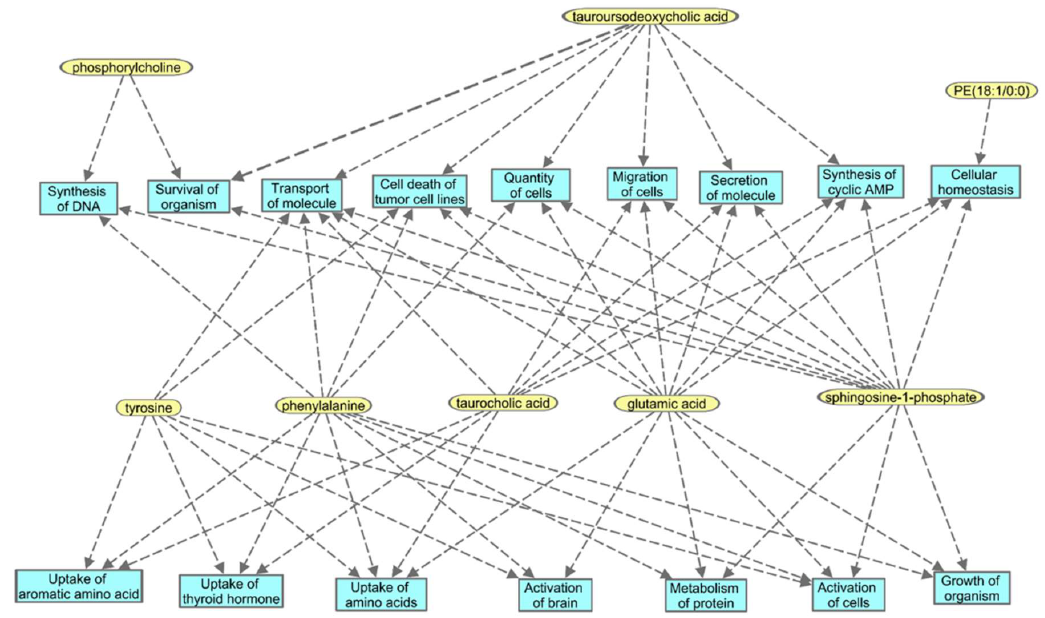
Figure 6. Functional pathway analyses for transient changes in metabolite expression identified changes in glycerophospholipid and bile acid metabolism in NHPs that received im BIO 300.